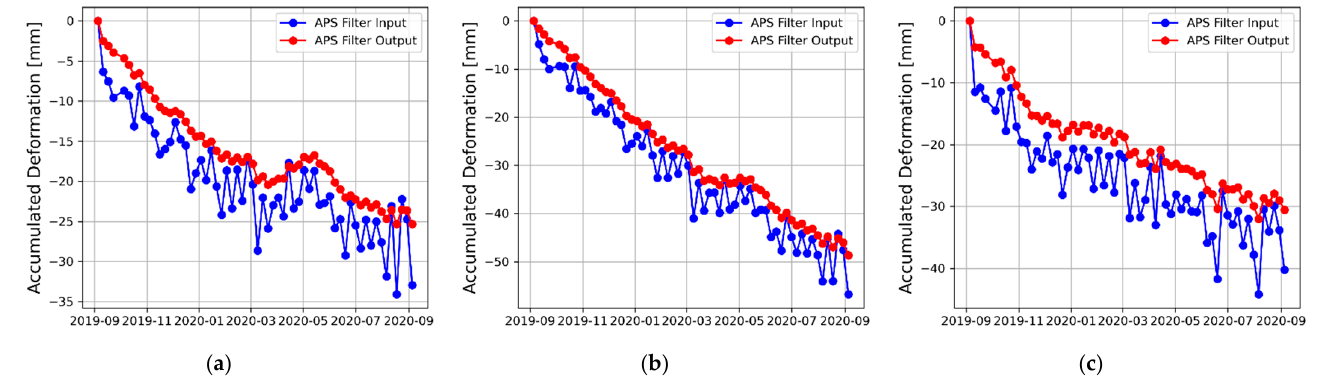
Figure 7. Accumulated deformation time series comparing the input and output of the APS filter, for three selected points associated with three different passive corner reflectors located in the vicinity of Biedrzychowa ( a , b ) and Pieszkowice ( c ).